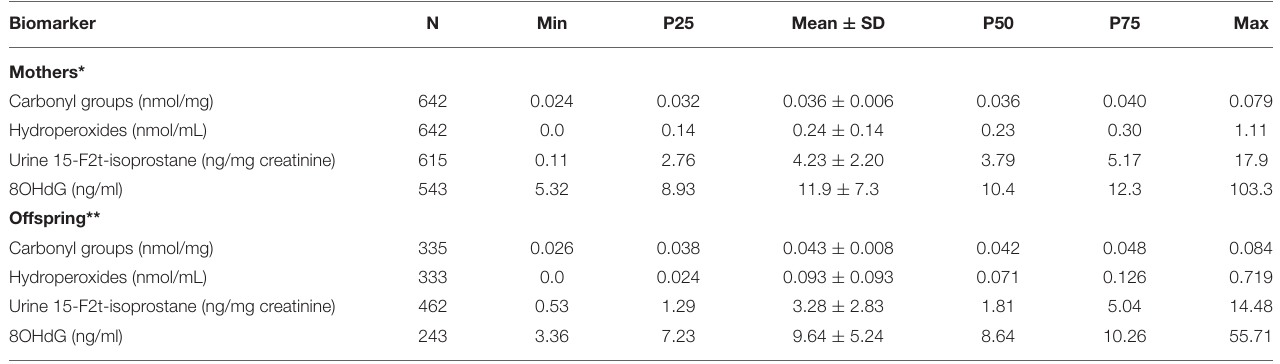
TABLE 2 | Distributions of the biomarkers of oxidative stress in mothers and their offspring, the NELA study. Biomarker N Min P25 Mean ± SD P50 P75 Max Mothers* Carbonyl groups (nmol/mg)